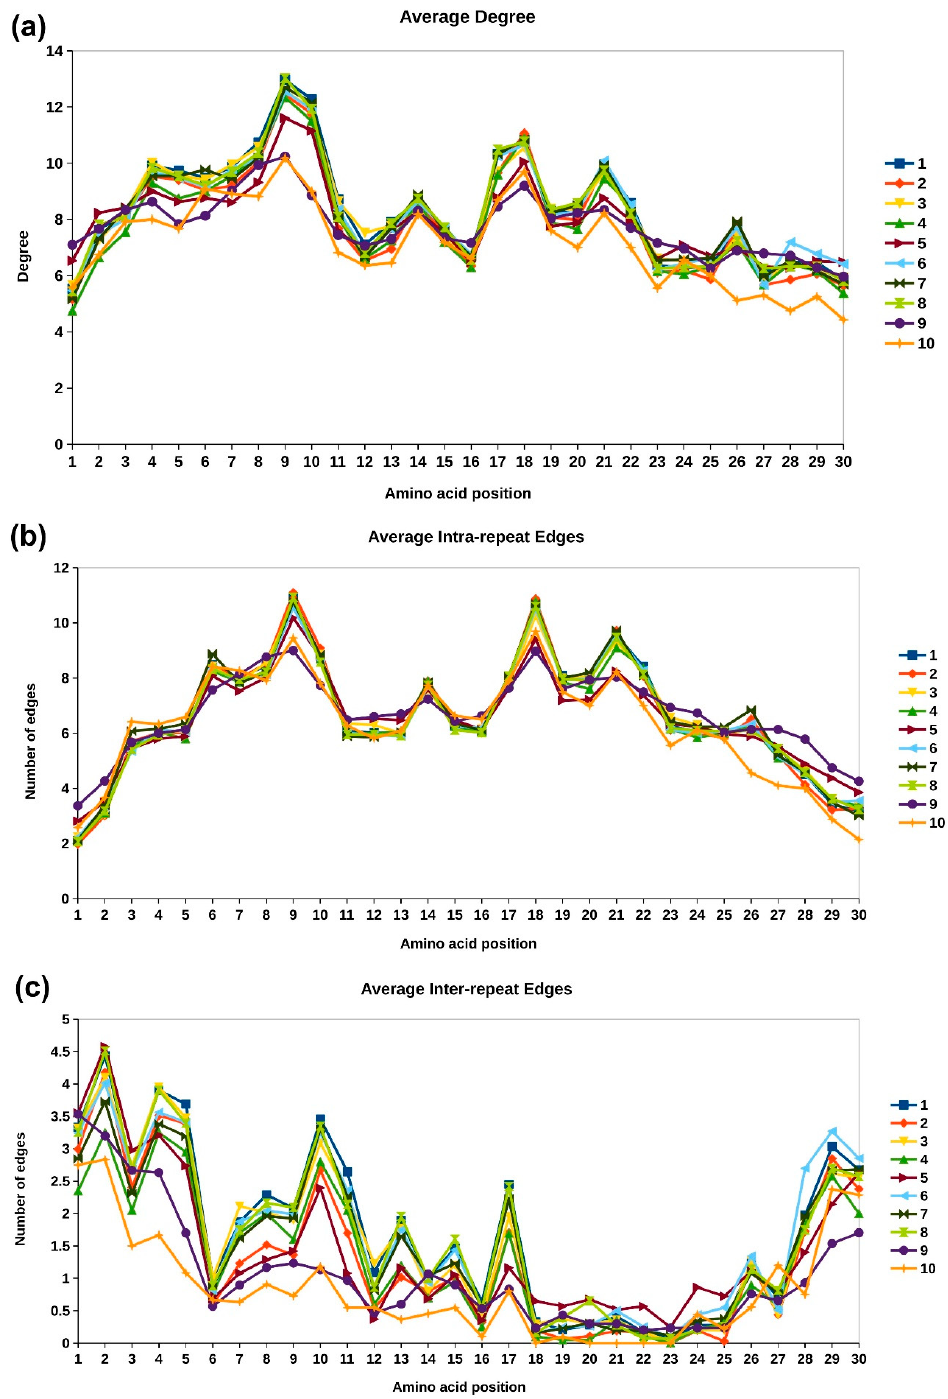
Figure 5. Amino acid connectivity information of the top 10 clusters. ( a ) Average number of connections (degree) for each amino acid positions within the repeat copy. ( b ) Average number of intra-repeat edges. ( c ) Average number of inter-repeat edges.